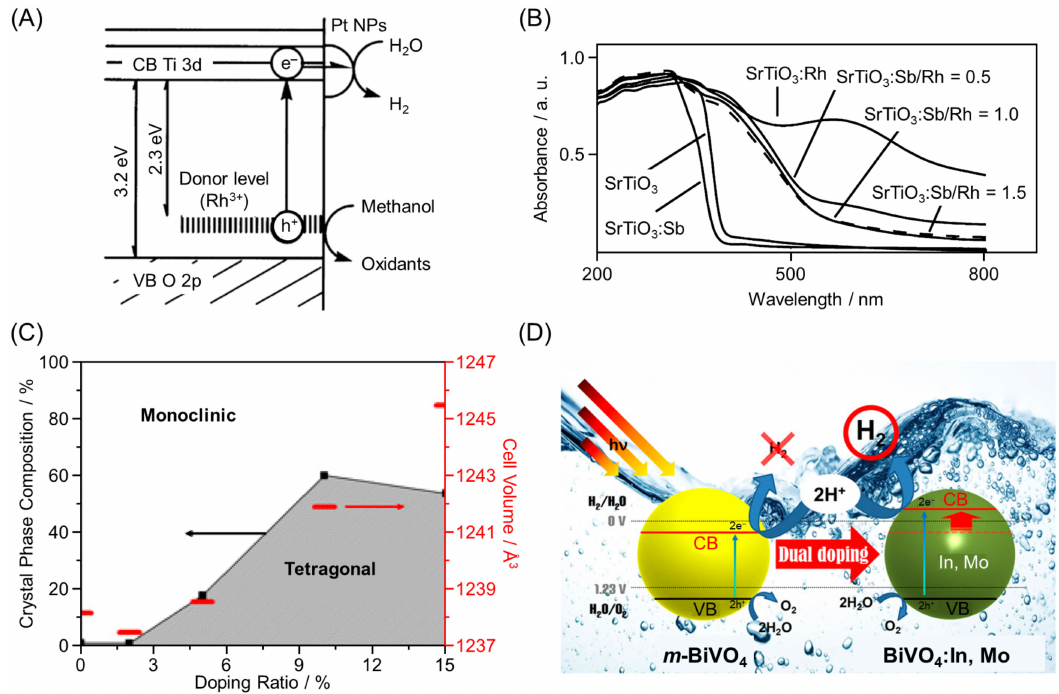
Figure 9. ( A ) Band structure of SrTiO 3 :Rh after photoreduction. ( B ) Diffuse reflection spectra of the six photocatalysts. For example, “SrTiO 3 :Sb/Rh = 0.5” indicates “SrTiO 3 :Sb,Rh in which Sb/Rh = 0.5”. ( C ) Crystal phase diagram with calculated unit cell volume for different doping ratios (atom ratios of In and Mo) of m -BiVO 4 . ( D ) Effect of dual doping by In and Mo on the activity of BiVO 4 . Reproduced with permission from references [119,125,128]. Copyright 2004 American Chemical Society, 2013 American Chemical Society, and 2015 National Academy of